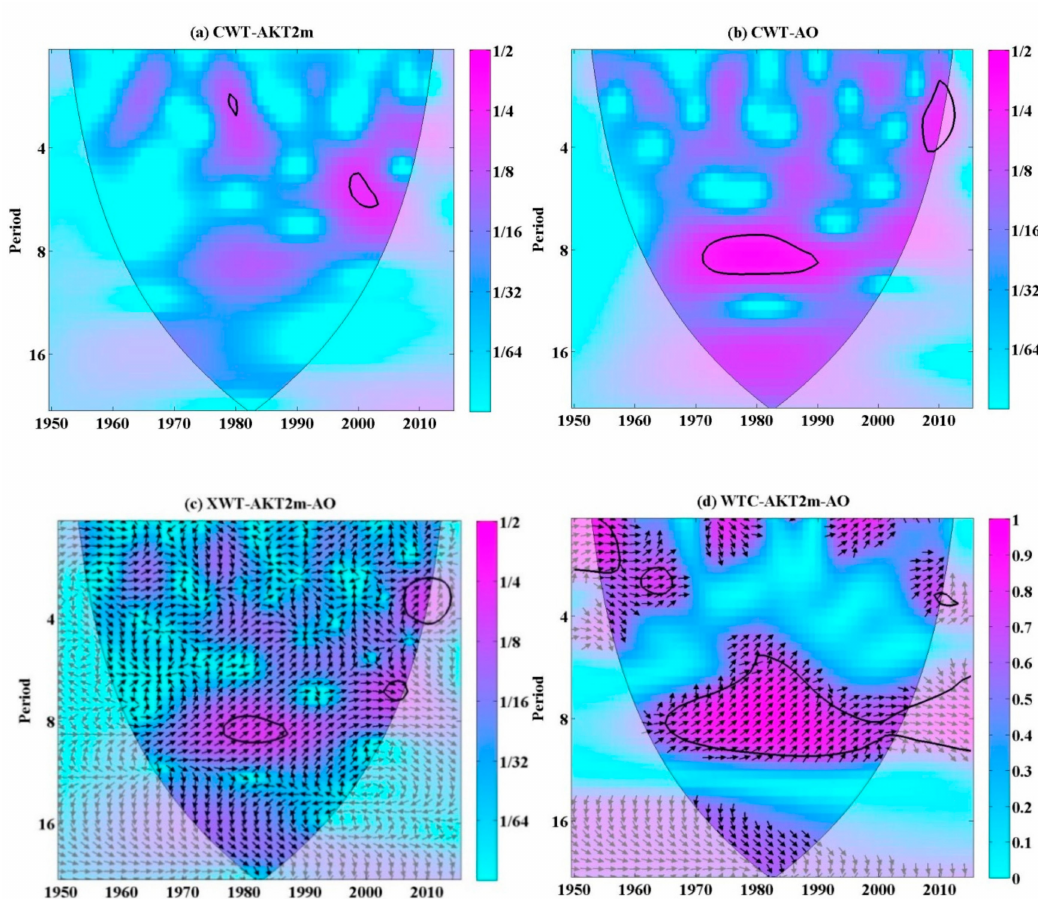
Figure 3. Continuous wavelet power spectra (CWT) for the standardized time series of the ( a ) AKT2m and ( b ) Arctic Oscillation; and the ( c ) cross-wavelet transform (XWT) and ( d ) squared wavelet coherence (WTC) between the AKT2m and Arctic Oscillation during the winters of 1950–2016. The thick black contour shows the 5% significance level against red noise and the thin black line indicates the cone of influence where edge e ff ects might distort the picture shown in a lighter shade. The phase relationship of the two time series is shown by the orientation of the arrows in the regions of high common power for XWT or high coherence for WTC—that is, phase arrows pointing right are in-phase, left is antiphase, down is AKT2m leading the Arctic Oscillation by 90 ◦ , and up is the Arctic Oscillation leading AKT2m by 90 ◦ . The phase angle can be quantified as a number of